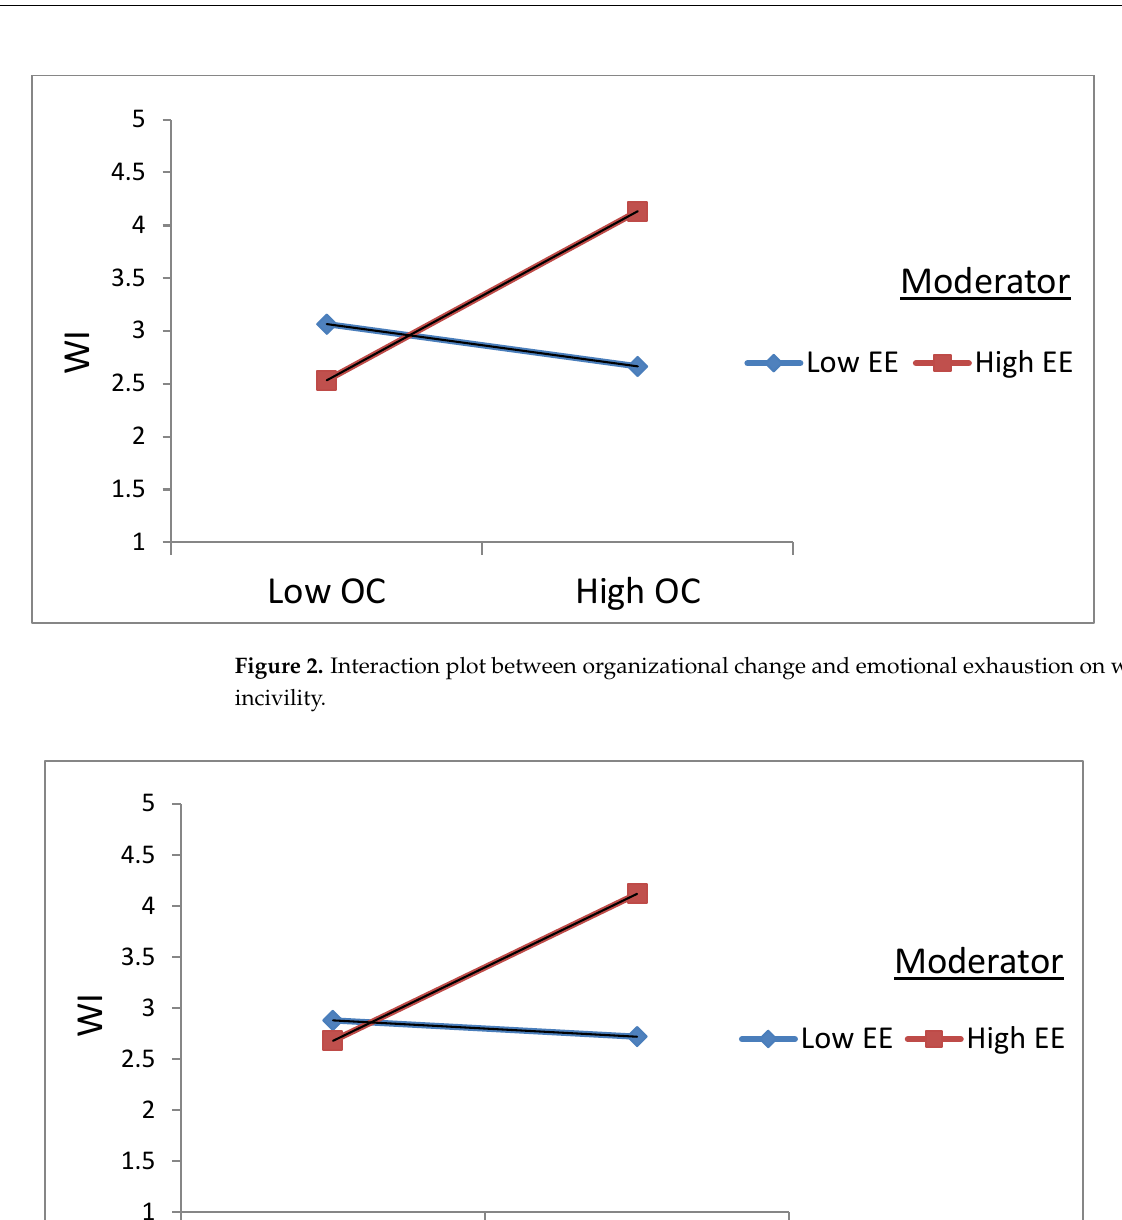
Figure 3. Interaction plot between Stress and emotional exhaustion on workplace incivility.